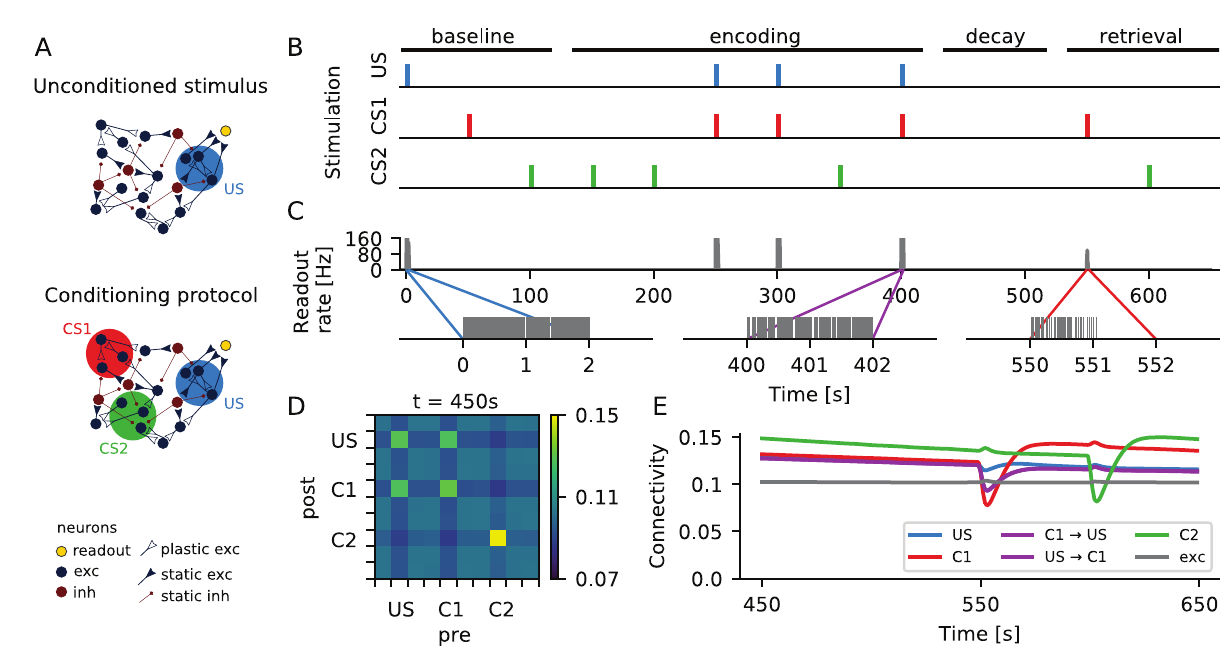
Fig 1. Formation of memory engrams in a neuronal network with homeostatic structural plasticity. (A) In a classical conditioning scenario, an unconditioned stimulus (US) was represented by a group of neurons that were connected to a readout neuron (yellow) via static synapses. The readout neuron spiked whenever neuronal activity representing the US was above a certain threshold (top). During a conditioning protocol, two other groups of neurons (CS1 and CS2) were chosen to represent two different conditioned stimuli (bottom). (B) During stimulation, the external input to a specific group of neurons was increased. The color marks indicate when each specific group was being stimulated. During the “encoding” phase, CS1 was always stimulated together with US, and CS2 was always stimulated alone. The time axis matches that of panel C (top). (C) Firing rate (top) and spike train (bottom) of the readout neuron. Before the paired stimulation (“baseline”), the readout neuron responded strongly only upon direct stimulation of the neuronal ensemble corresponding to the US. After the paired stimulation (“retrieval”), however, a presentation of C1 alone triggered a strong response of the readout neuron. This was not the case for a presentation of C2 alone. (D) Coarse grained connectivity matrix. Neurons are divided into 10 groups of 100 neurons each, shown is the average connectivity within each group. After encoding, the connectivity matrix indicates that engrams were formed, and we found enhanced connectivity within all three ensembles as a consequence of repeated stimulation. Bidirectional inter-connectivity across different engrams, however, is only observed for the pair C1-US that experienced paired stimulation. (E) Average connectivity as a function of time. The connectivity dynamics shows that engram identity was strengthened with each stimulus presentation, and that engrams decayed during unspecific external stimulation.